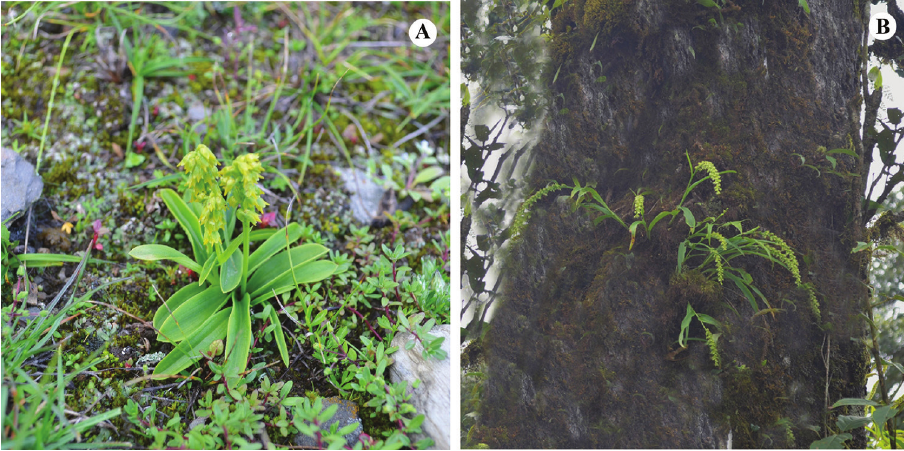
Figure 2. Habitat of Herminium . A H. chloranthum (Terrestrial) B H. quinquelobum (Epiphytic on tree trunk).